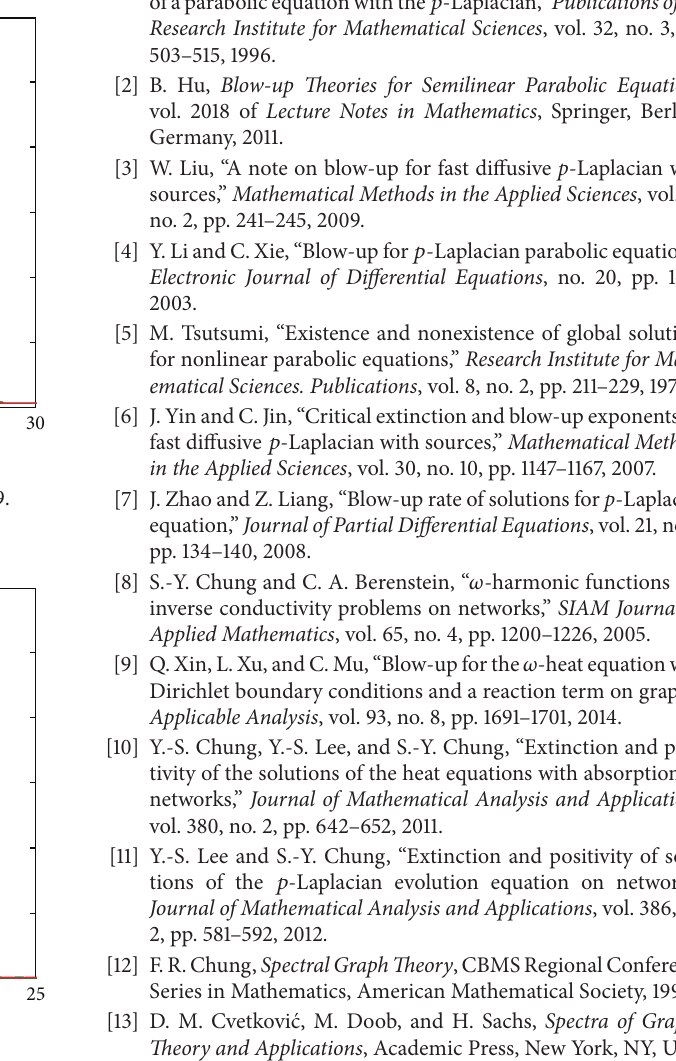
Figure 4: Behavior of each node for 𝑝 = 1.5